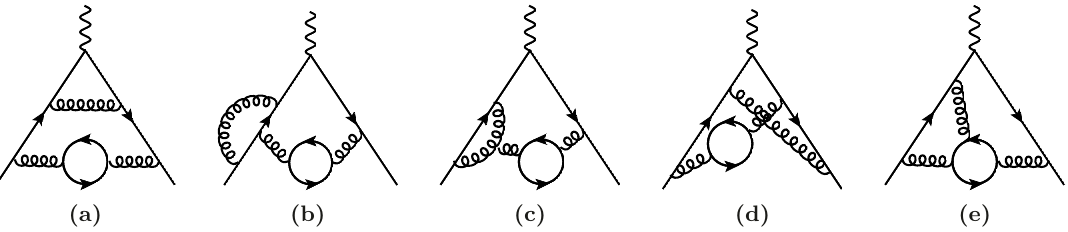
Figure 4. Sample diagrams contributing to F 1 and F 2 at three-loop order. Solid, curly and wavy lines represent quarks, gluons and photons, respectively. In our calculation we only consider contributions with at least one closed massless quark loop.